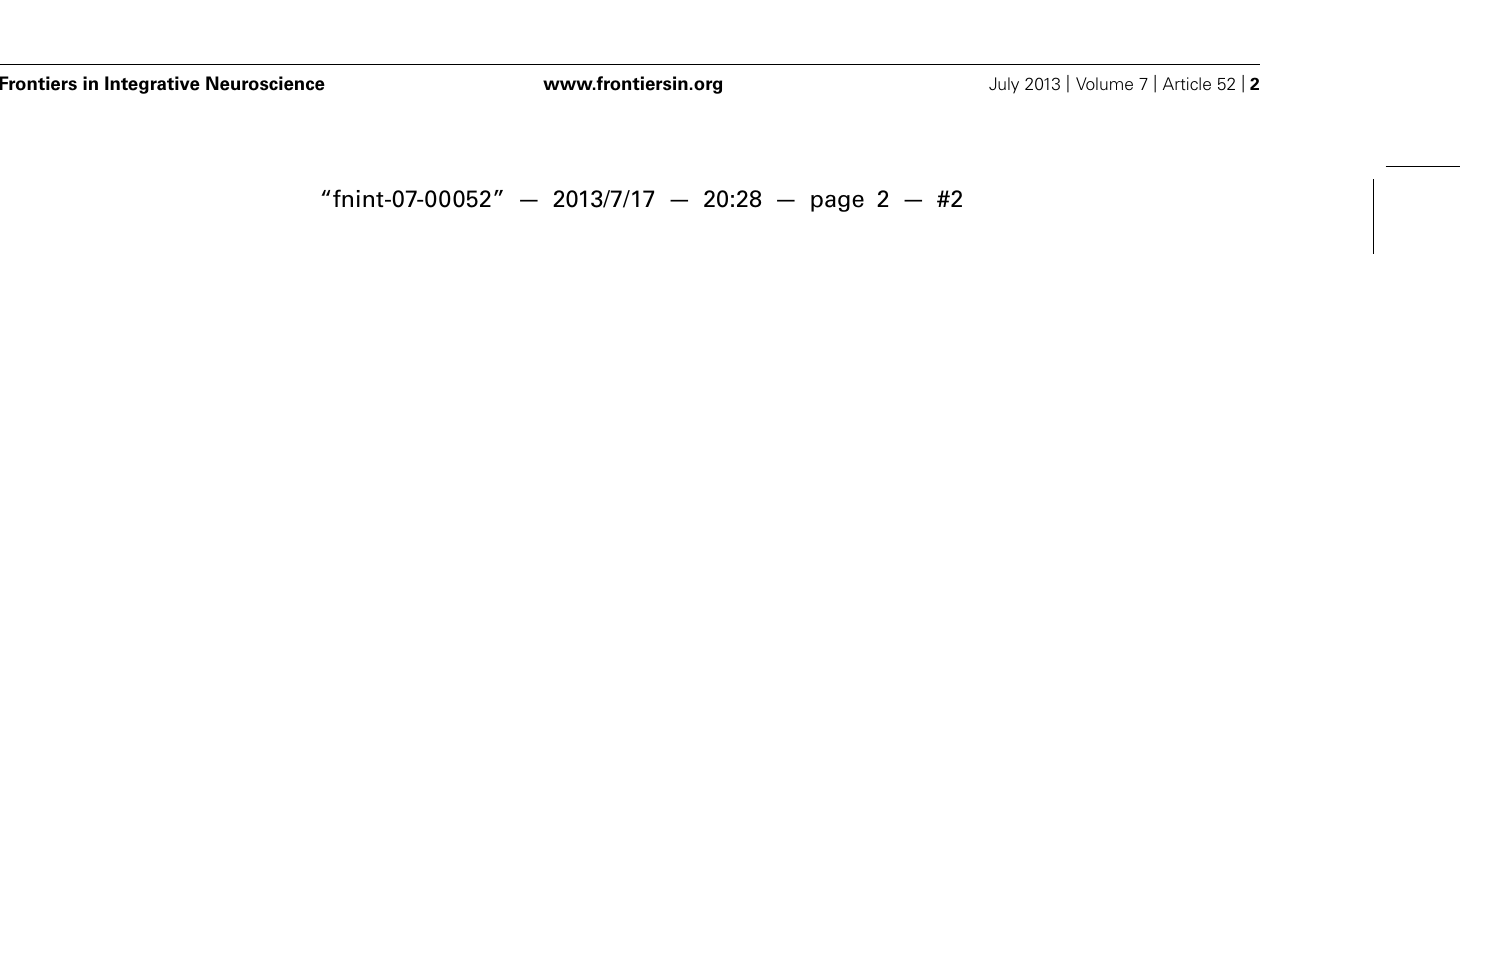
FIGURE 1 | Behavioral paradigms and stimuli. (A) Both the detection and discrimination task were based on the same general procedure.Visual targets were shown for one frame ( ∼ 16 ms) at a random time point after the onset of a fixation dot. Subsequently a question mark cued subjects to respond by pressing a button on a keyboard.Targets were always accompanied by a sound, which could be either “informative” or “non-informative.” (B) Detection task.Visual targets (letters “A” or “P”) were presented at eight different locations (orange boxes) of the visual field that were either central (5 ◦ from fixation dot) or peripheral (14 ◦ ). Subjects had to indicate in which hemifield relative to the horizontal midline the target appeared.The informative sound reduced spatial uncertainty about target location by being lateralized (left or right speaker only), while the non-informative sound provided only temporal co-stimulation (stereo sound).The reduction in stimulus uncertainty by the informative sound is indicated in blue on the right. (C) Discrimination task.The same visual targets were presented at four positions along the horizontal midline at either central (5 ◦ ) or peripheral (14 ◦ ) locations. Subjects had to indicate the orientation of the letter (upright, upside down).The informative sound reduced uncertainty about the letter (sound “A” or ”P”; stereo), while the non-informative sound (“O”) provided only temporal